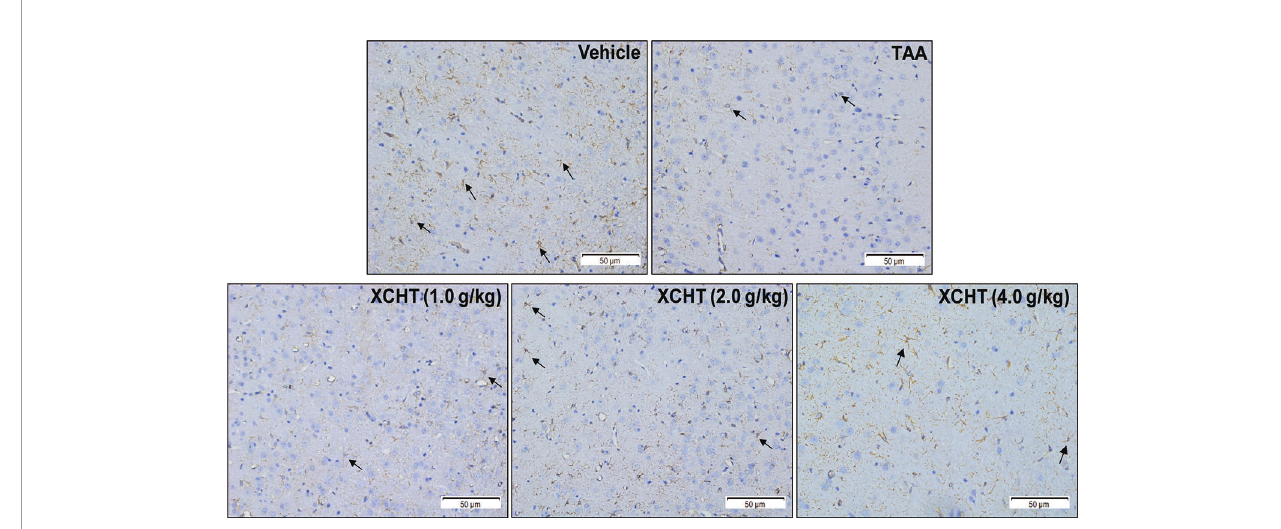
FIGURE 4 | Effect of XCHT on structure of the astrocytes in cerebral cortex of AHE rats. GFAP expression in cerebral cortex of rat brain (IHC, 200×). The decrease of GFAP immunostaining in cortex of TAA group rats compared to the vehicle group, which indicated that the structure of astrocytes was destroyed and brain edema occurred. In contrast, the expression of GFAP in astrocytes increased in the treatment groups with different